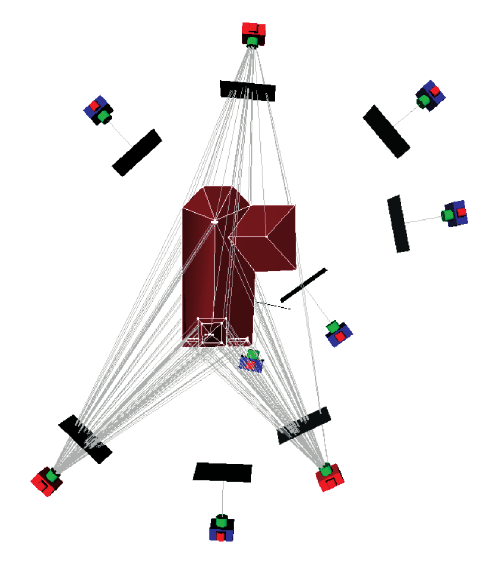
Fig. 8. Wireframe model connected with the photograph